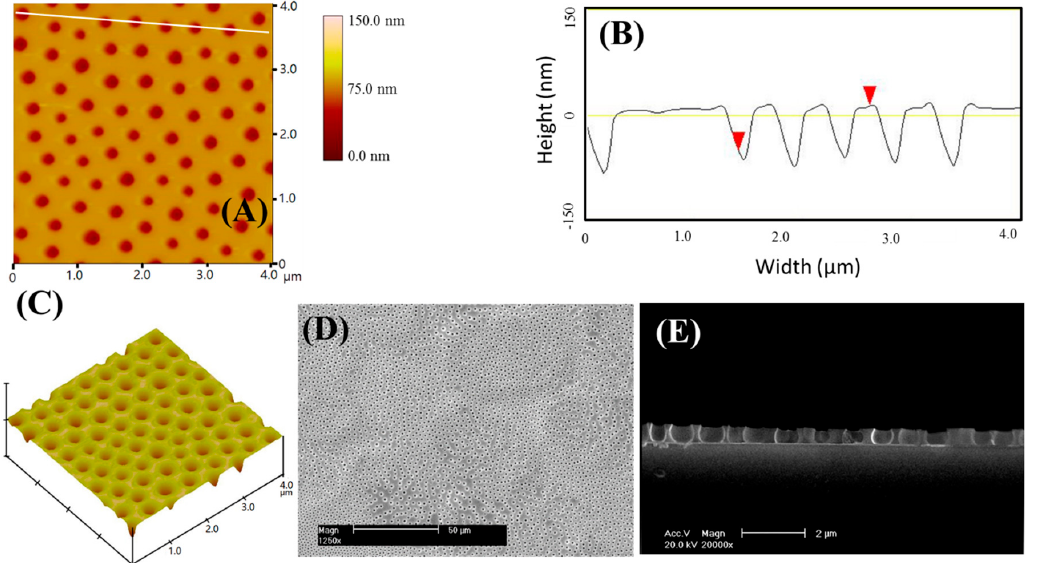
Figure 1. ( A ) AFM image of PS– b –PAA microporous solid thin film; ( B ) Cross-section of the PS– b –PAA